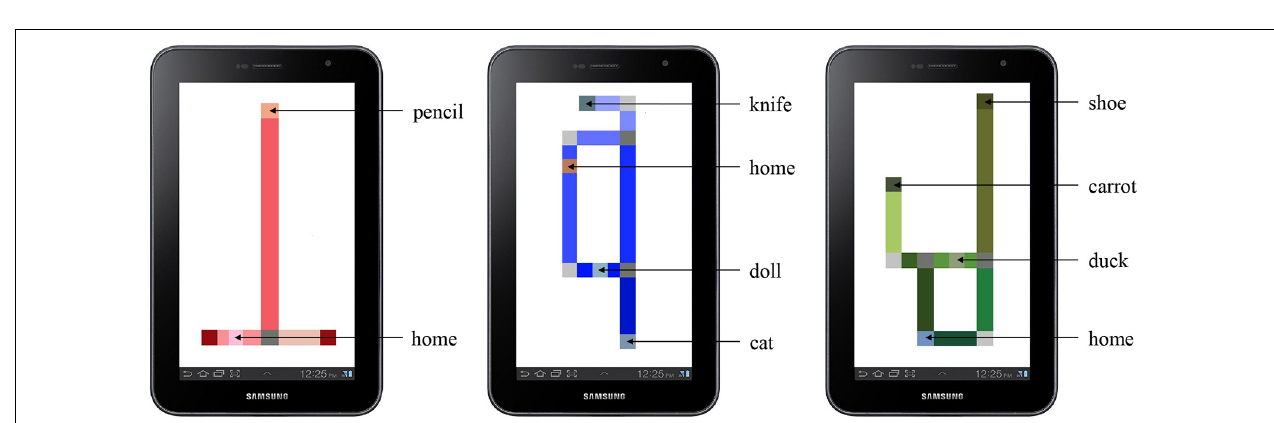
FIGURE 2 | The practice map (left) and experimental maps (center and right) as rendered on the tablet. The home and target object locations are labeled.